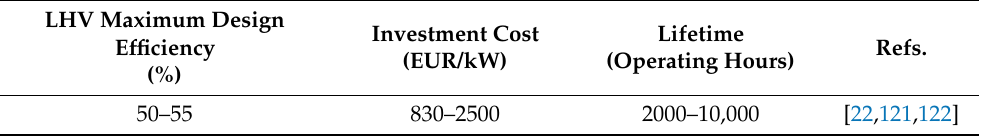
Figure 5. Simplified schematic of the typical configuration of a water-cooled PEMFC system, including the main components of the BoP. For simplicity, not all components of the power conditioning, control, and monitoring subsystem of the BoP have been reported in the schematic. Elaborated from [120]. Table 4. Techno-economic data for PEMFC stacks. Ranges extend from minimum to maximum values of the parameters found in the available literature studies. Data do not explicitly refer to maritime PEMFCs due to the lack of data for maritime PEMFCs.